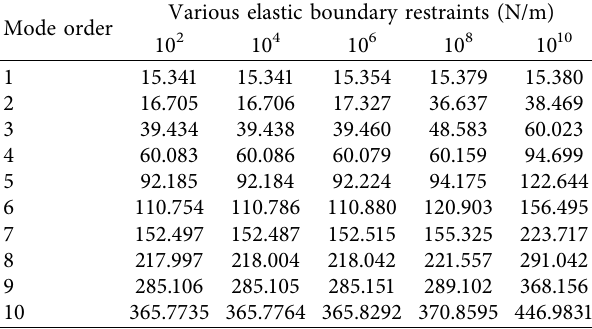
Table 6: The first ten natural frequencies of original model under various elastic boundary restraints at the right